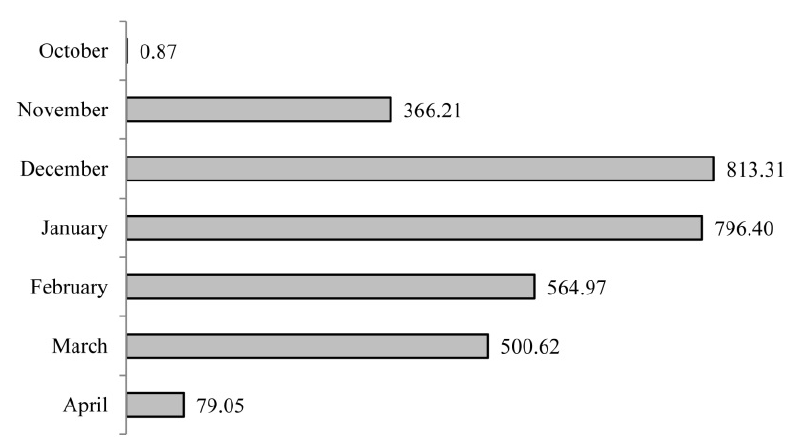
Figure 8. Flat energy need for heating (monthly average, kWh).